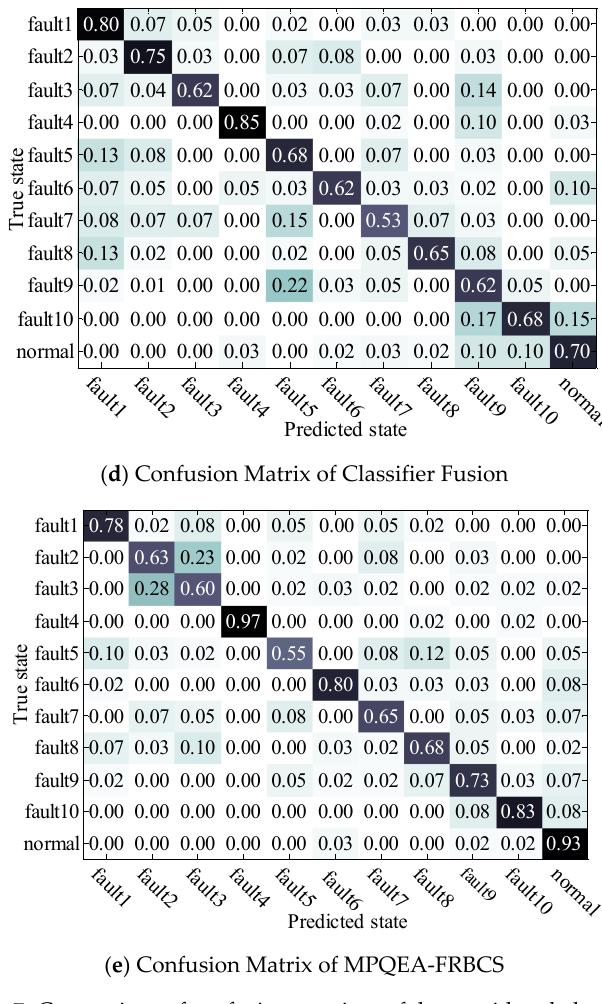
Figure 7. Comparison of confusion matrixes of the considered algorithms.